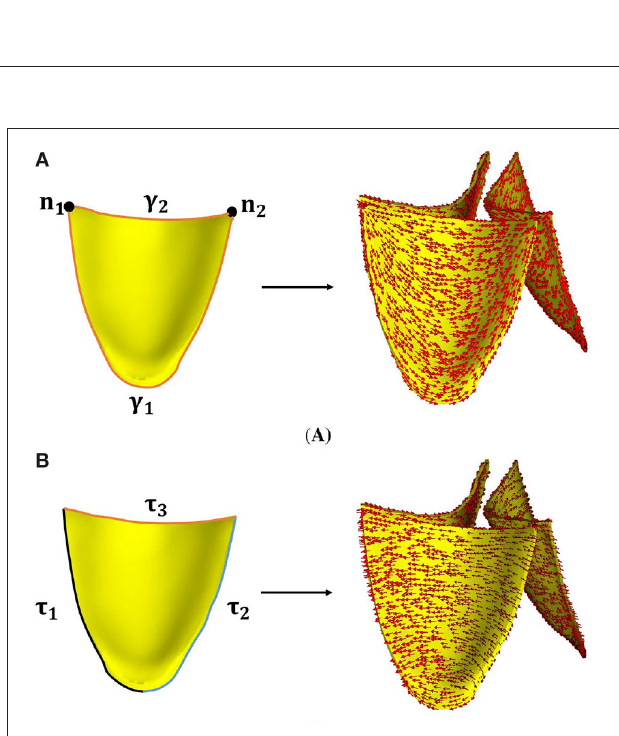
FIGURE 2 | Two different fiber architectures of AV leaflets, (A) FD1, (B)